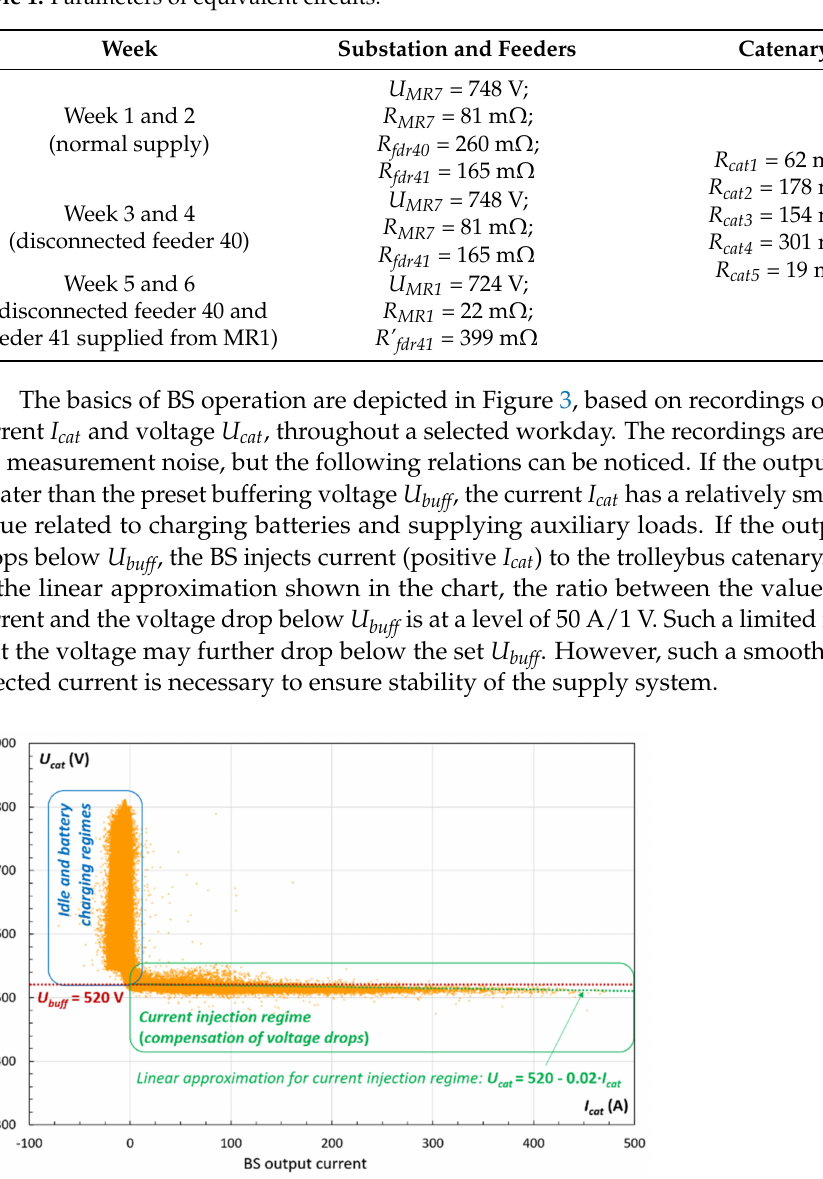
Table 1. Parameters of equivalent circuits.